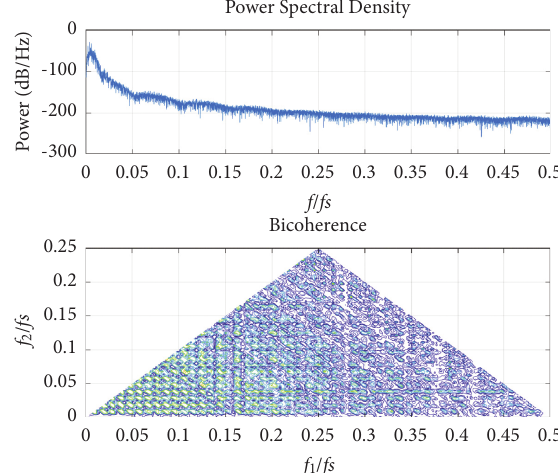
Figure 4: Power spectral density and the bicoherence for fractional-order power system